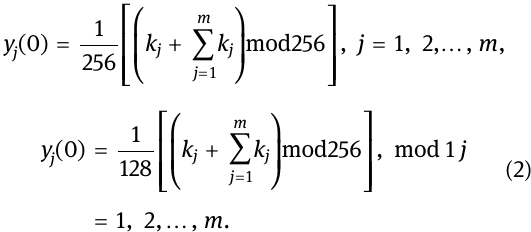
Algorithm 1. Chaotic sequence used for image